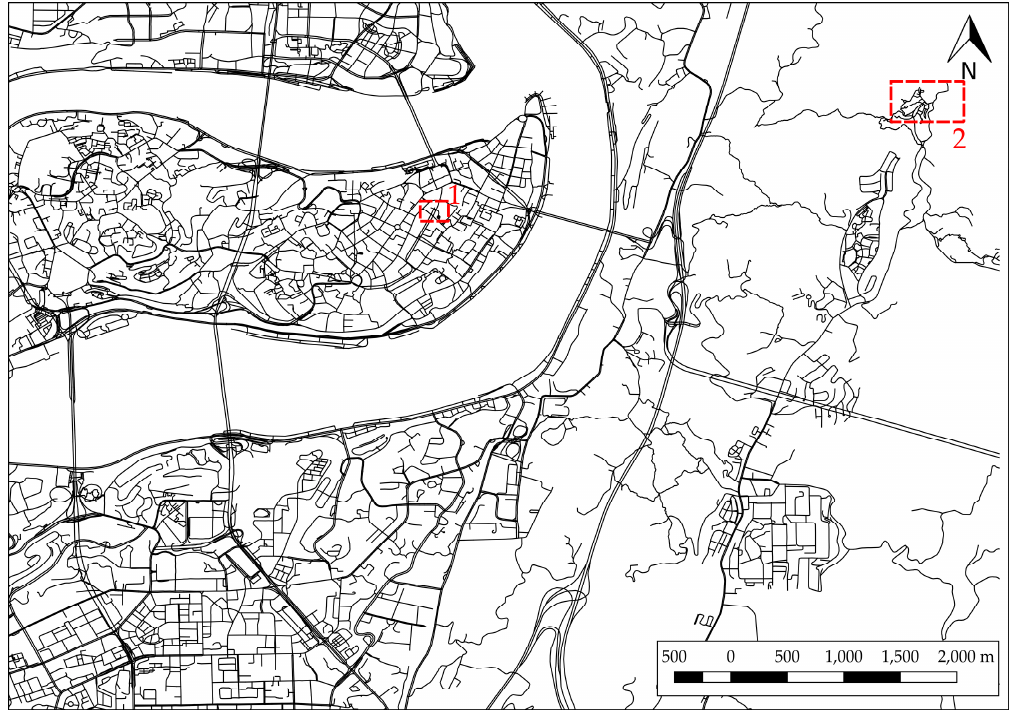
Table 1. The parameters and threshold setting of the genetic algorithm.